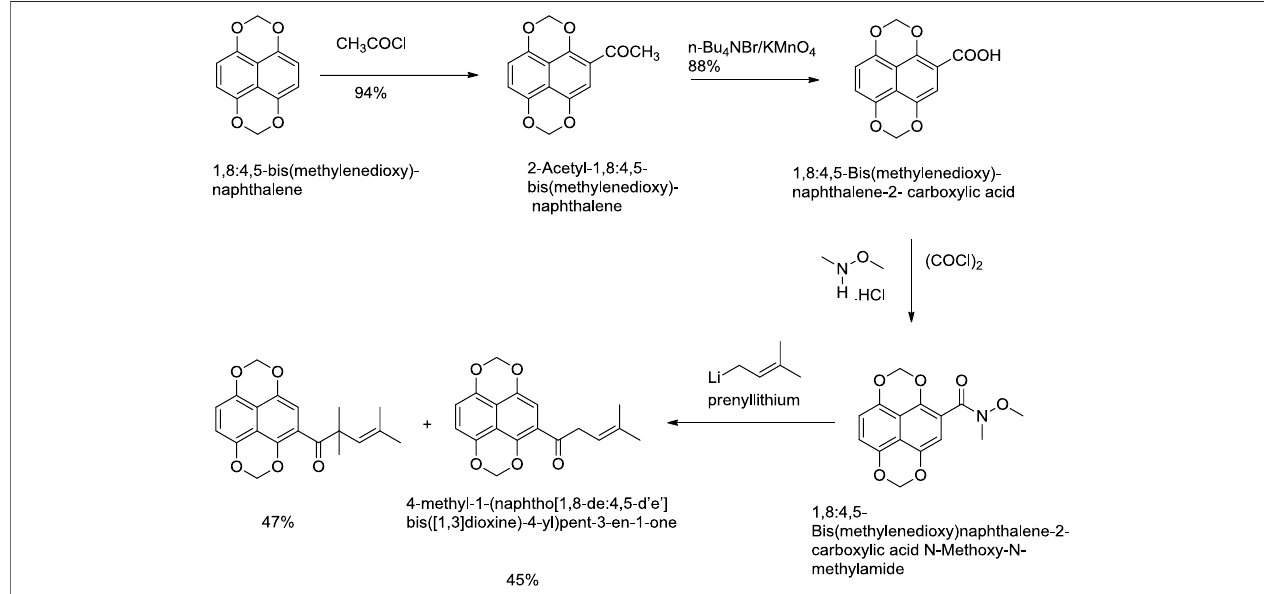
SCHEME 12 | A new synthesis for the preparation of key intermediate for Nicolaou total synthesis (Zheng et al., 2021).